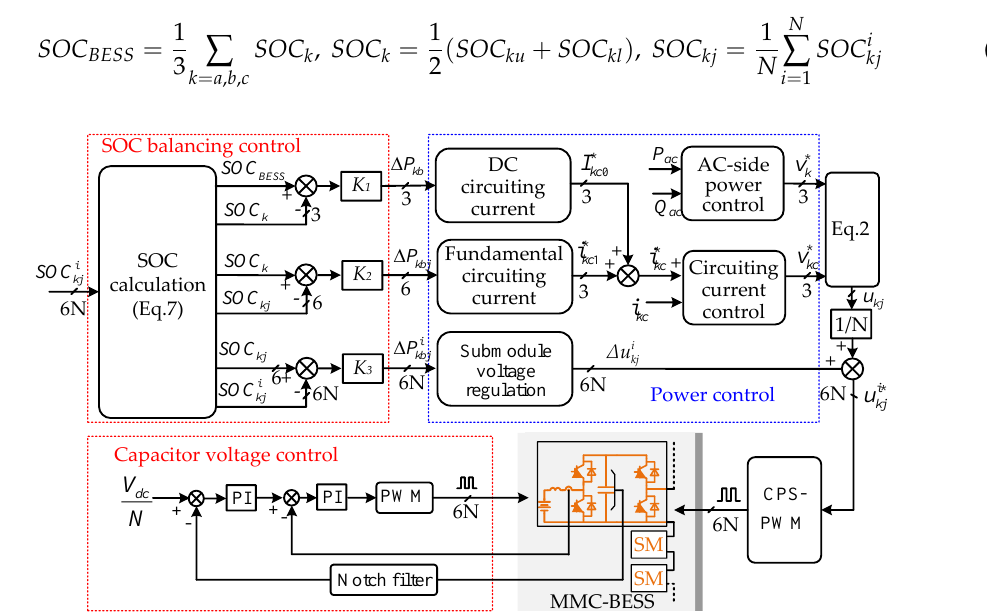
Figure 3. General control structure of MMC-BESS.